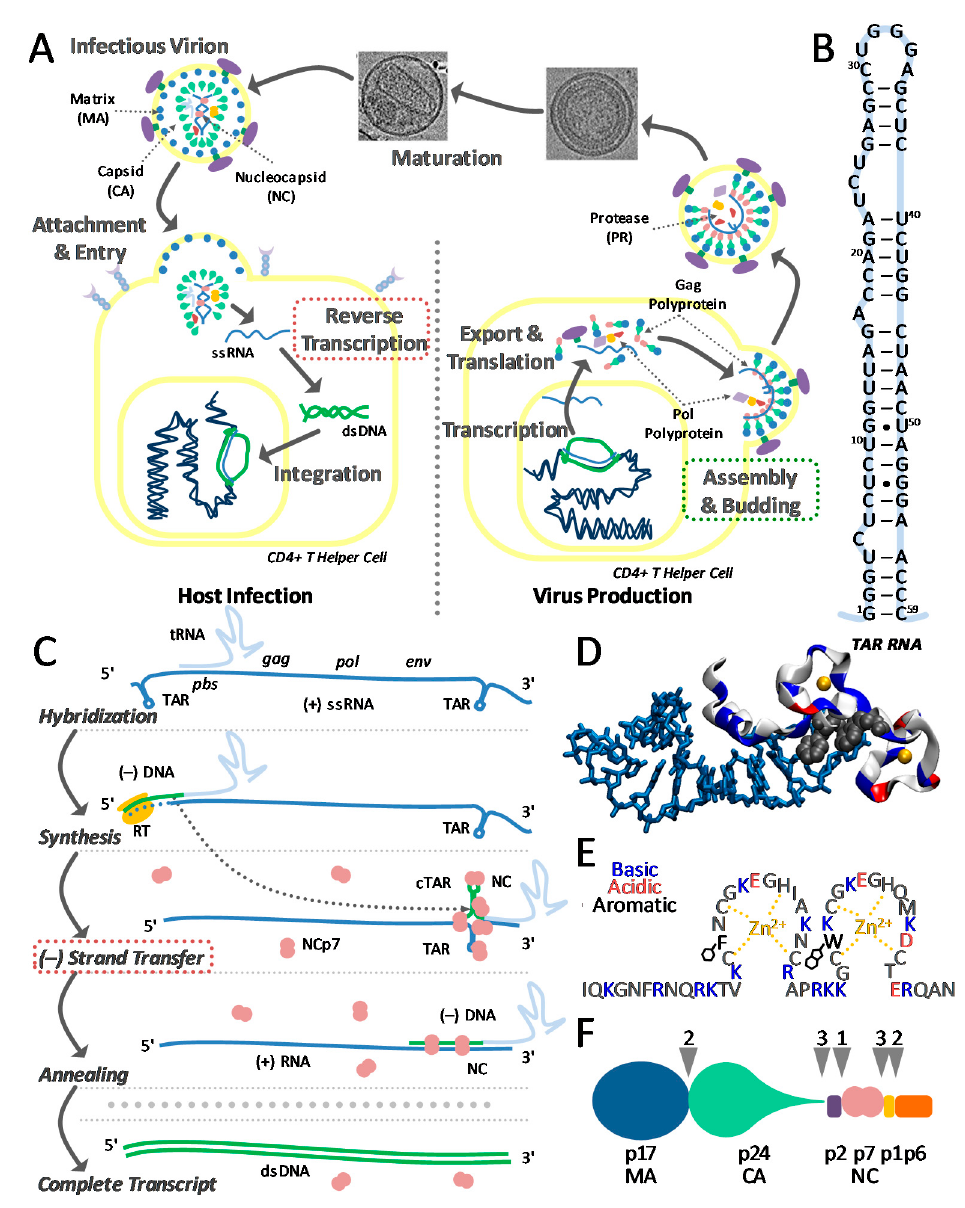
Figure 1. Critical steps in the viral life cycle. ( A ) In a standard picture of the infection, the virion attaches to a host cell and releases the viral RNA, which must undergo reverse transcription before integration. An infected cell will transcribe viral polyproteins, including the group-specific antigen (Gag). Polymerizing upon the host cell wall, Gag packages two RNA strands into the nascent virus. Reverse transcription may not occur until the nucleocapsid domain NCp7 is cleaved from Gag. ( B ) The folded structure of the 59-base transactivation response (TAR) RNA hairpin is highly irregular, with several bulges and mismatches. ( C ) Nucleic acid chaperone NCp7 facilitates minus strand transfer, a rate-limiting step in reverse transcription, where viral RNA (blue line) is converted into DNA (green line). ( D ) The sequence of NCp7, highlighting two zinc finger domains, responsible for nucleic acid binding and destabilization, and a basic tail (blue residues) responsible for chaperone activity. ( E ) NMR structure of the nucleocapsid (NC) bound to SL3, where two aromatic residues (black) stack with exposed bases (PDB code 1a1t) [17]. ( F ) Progressive cleavage (arrows) of Gag polyprotein by viral protease-free NCp7 as well as the matrix (MA) and capsid (CA) domains [18,19] . The nucleocapsid protein NCp7 consists of 55 amino acids, forming two functional subdomains (Figure 1D). A basic tail serves as an effective aggregator of DNA and RNA. The other subdomain coordinates two zinc ions, often referred to as zinc ‘fingers’, which contribute to nucleic acid binding